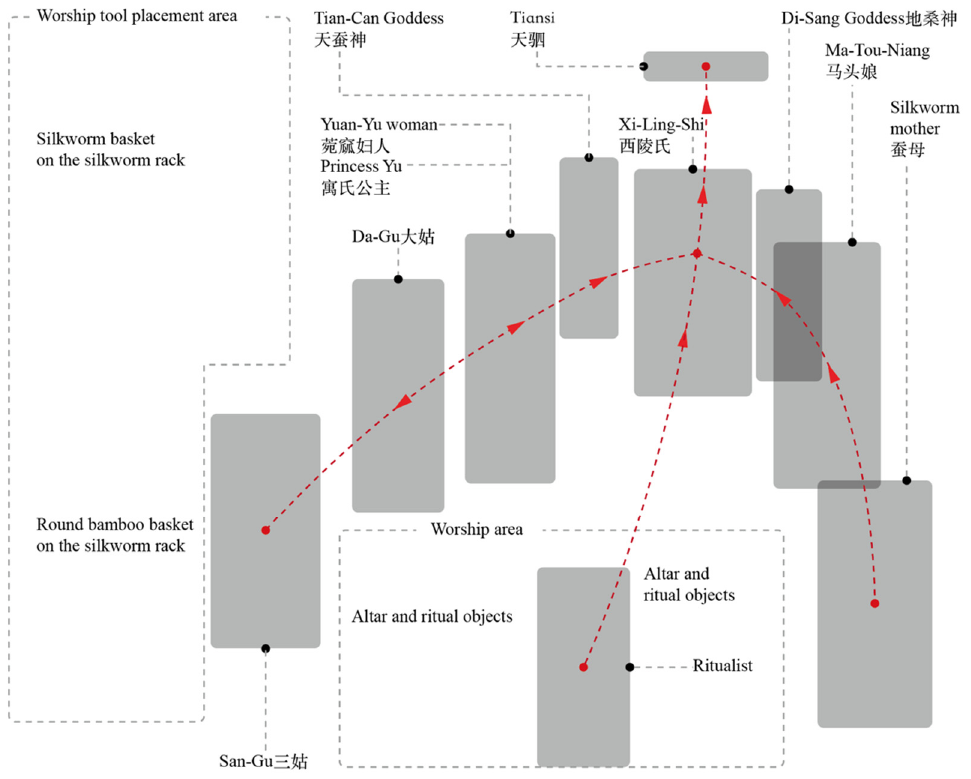
Figure 4. Silkworm deity, worshippers, and sacrificial tools in the illustrations of “Silkworm deity”. Drawn by the authors.